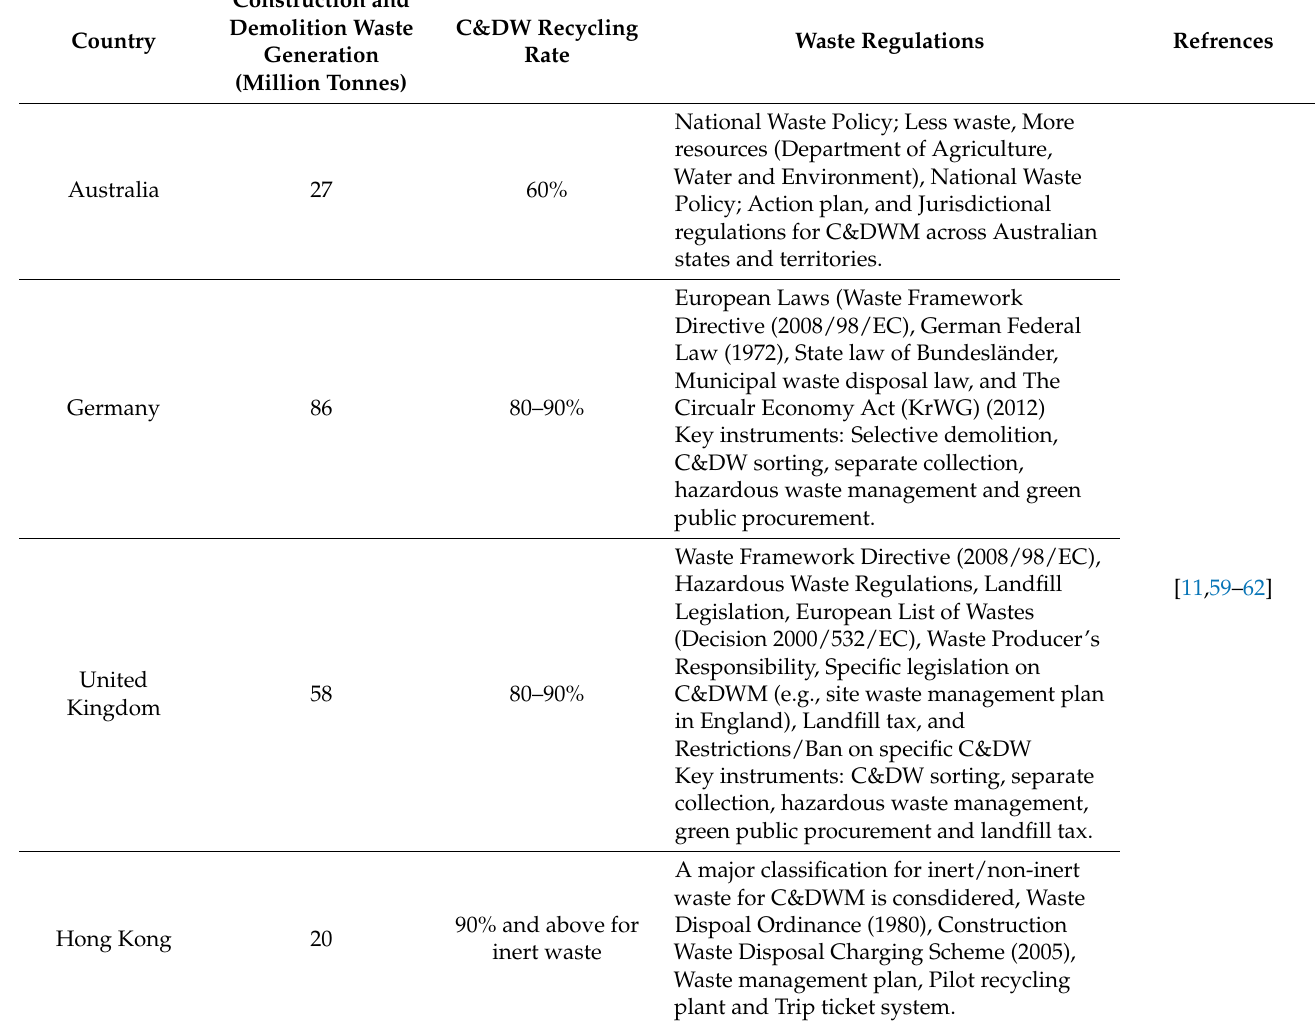
Table 2. Construction and demolition waste management in Australia, Germany, United Kingdom and Hong Kong. Construction Country